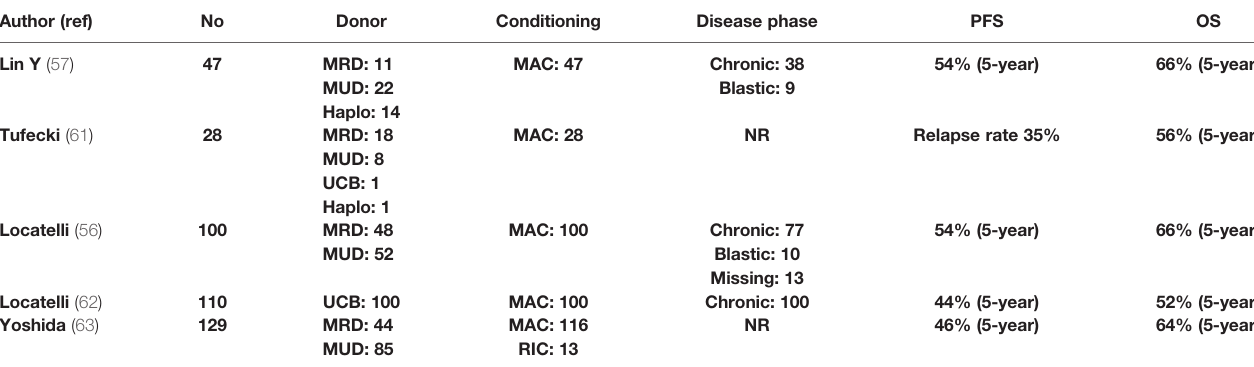
TABLE 2 | Allogeneic stem cell transplantation in patients with JMML.